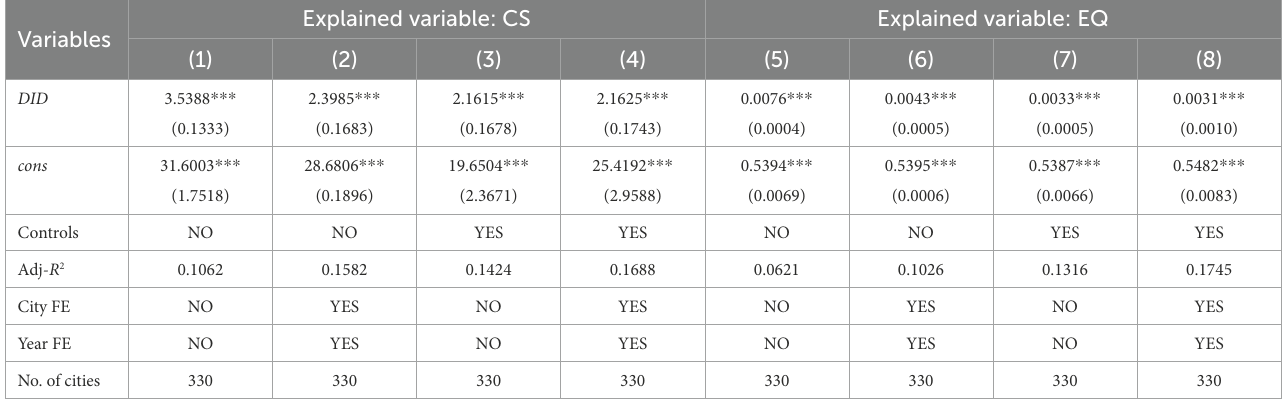
TABLE 2 Results of baseline